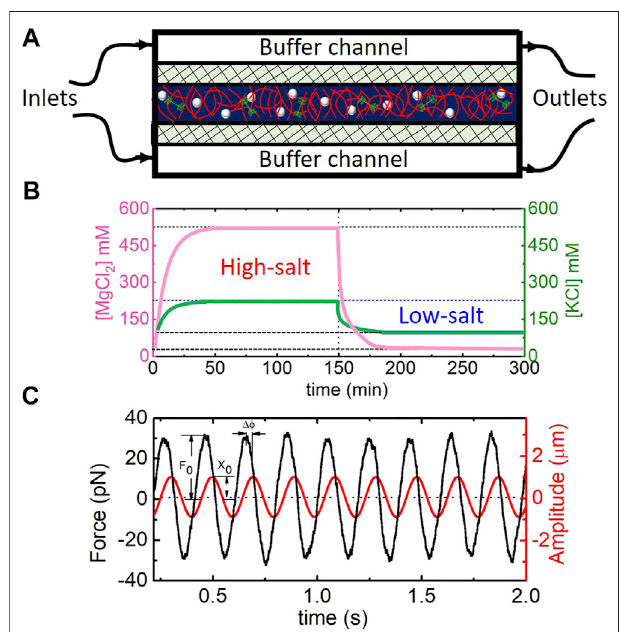
FIGURE 1 | Experimental approach to measuring the time-varying microrheological response of actomyosin networks subject to in situ salt modulation. (A) Schematicofmicro fl uidicdevicecontainingacentralchamber that holds the sample of actin (red), myosin II (green), and microspheres (white); fl anking Buffer channels used to pull in new buffer (through the Inlet) and remove existing buffer ( via the Outlet), and two semipermeable membranes (crosshatches) to allow for buffer exchange via passive diffusion. Cartoon is not drawn to scale. (B) Plot depicting the concentrations of Mg 2+ and K + in the sample chamber as a function of time, enabled by in situ buffer exchange via the micro fl uidic device. Initial [Mg 2+ ] and [K + ] of 1 and 50 mM, respectively, and are increased to 500 and 200 mM over ∼ 10 min. After 150 min, [Mg 2+ ] and [K + ] are reduced back to initial concentrations for the remaining 150 min. Curves shown are those expected based on concentration measurements from Ricketts et al. [33]. (C) Sample data trace from optical tweezers microrheology experiment showing measured stage position (red) and force exerted on the microsphere (black) over the course of the 2 min acquisition time. The amplitude of the force F 0 and position x 0 , as well as the phase shift Δ ϕ between the two oscillations, are used to determine viscoelasticmoduli G ′ and G ″ .Datashownisforafrequencyof ω (cid:1) 32 rads − 1